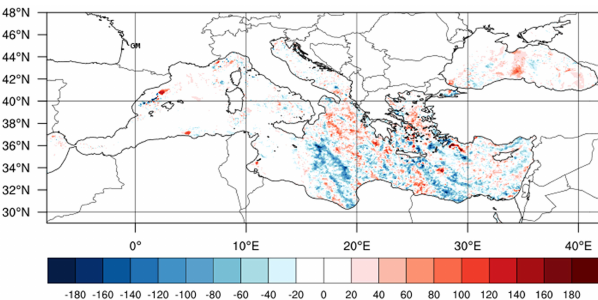
Figure 13. Spatial distribution of the averaged PBL height (in m) difference (WEW – CTRL) for the period 6–7 January